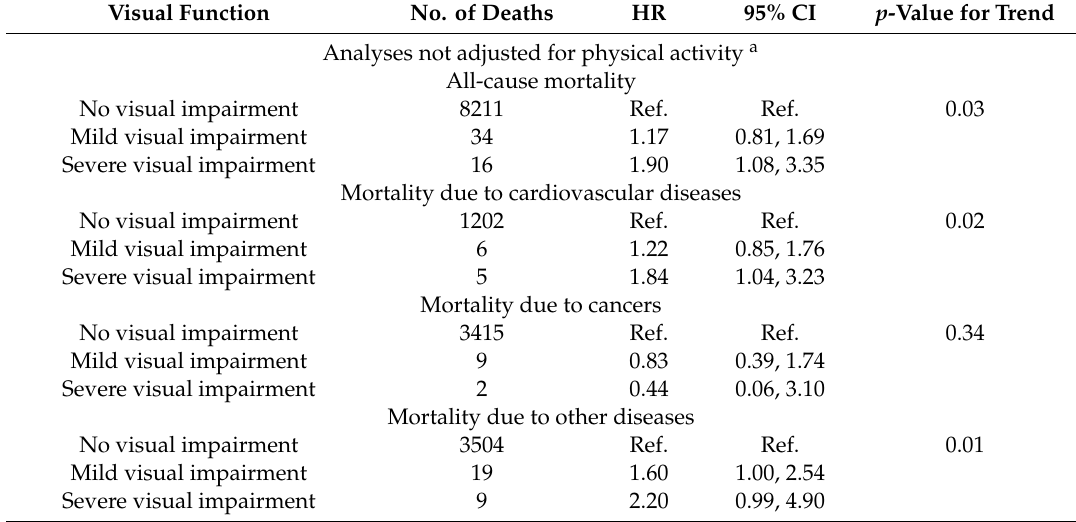
Associations between visual impairment and mortality among the Korean national health